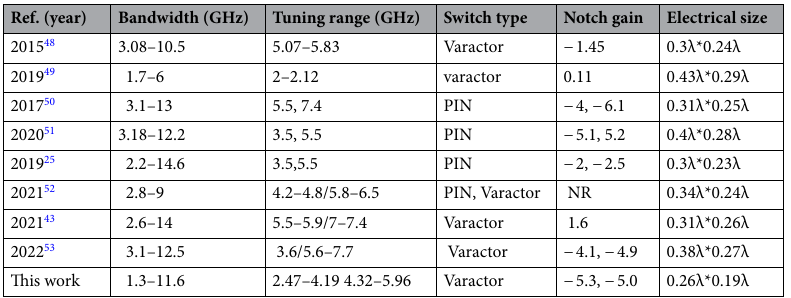
Table 3. Comparation of the proposed tunable band-notched antenna and related designs. λ is the guided wavelength at the lowest frequency of the operating band